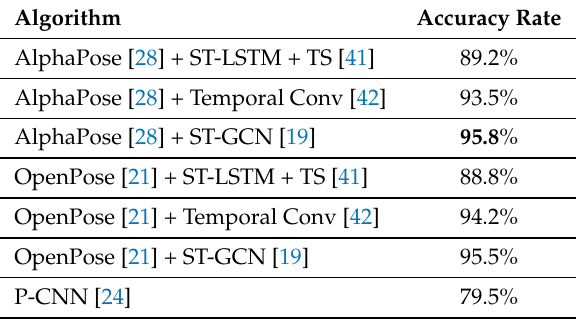
Table 4. Comparative experiments on our 6-class action dataset (5.2 k training samples and 600 test